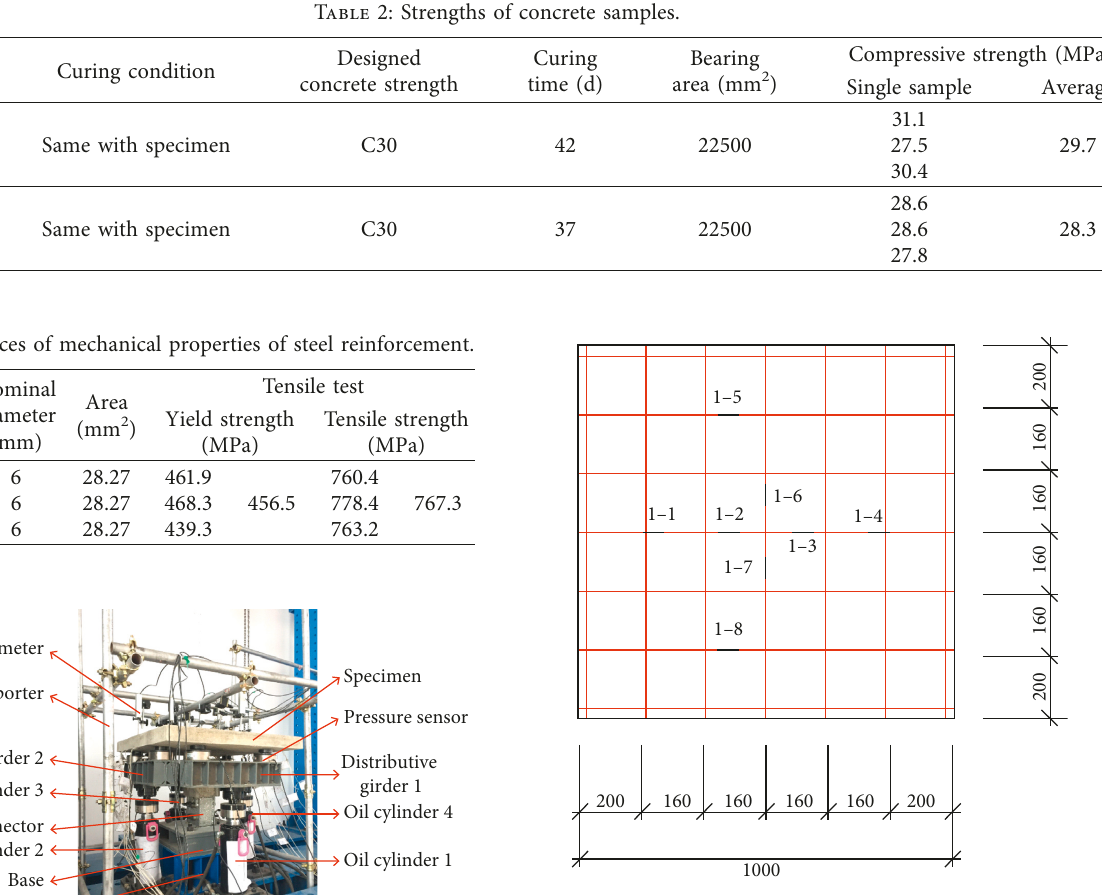
Figure 4: Typical strain gauges arrangement of steel reinforcement for the